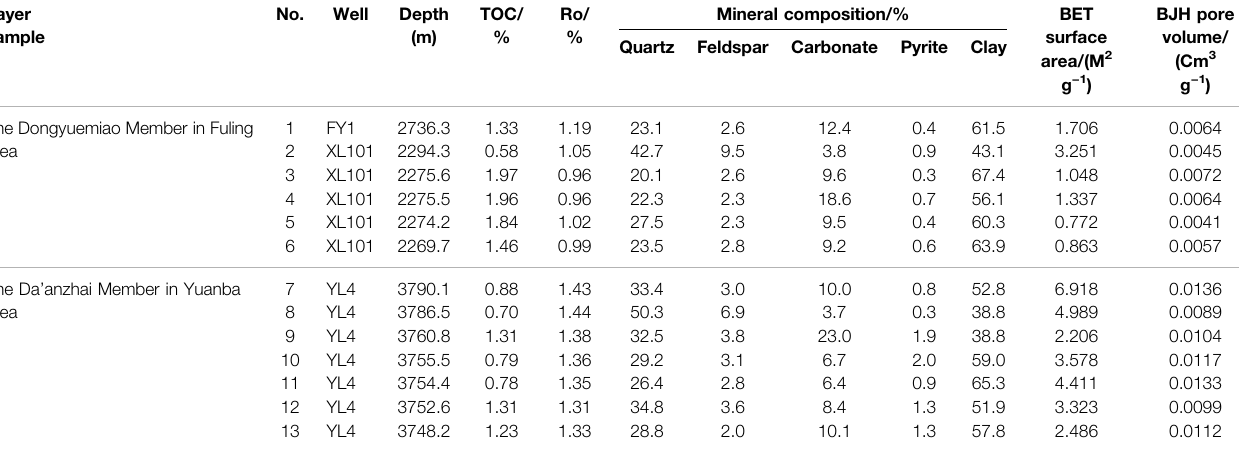
TABLE 1 | Total organic carbon ( TOC ), mineralogical composition, and pore structure parameters of shale samples. Layer sample